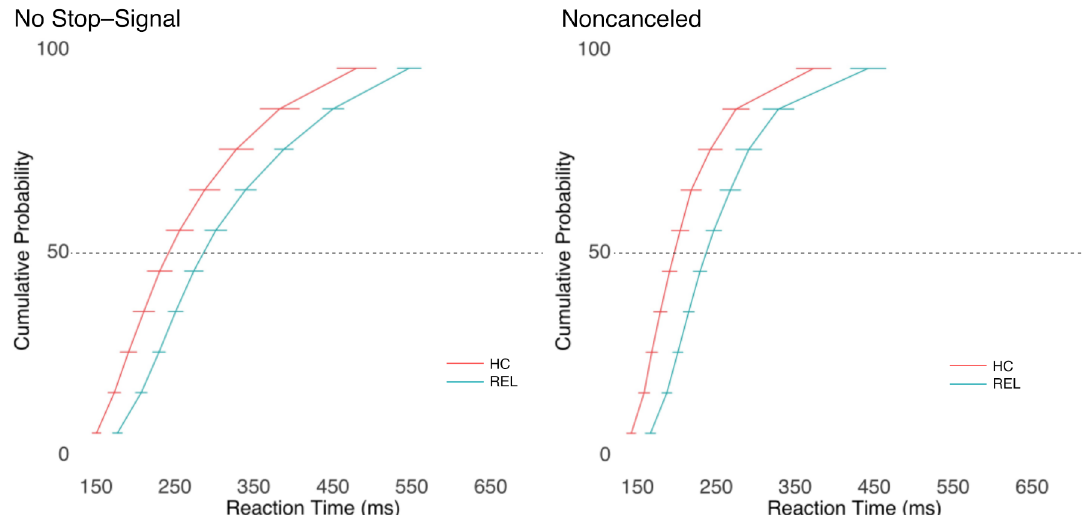
Figure 3. Vincentized RT distributions for no stop-signal trials ( left panel ) and noncanceled stop-signal trials ( right panel ) for experiment 1. The reaction times for each participant were binned into deciles split by trial type in order to visualize the distributions, which complimented the ANOVAs examining the mean reaction times that are reported in the main text. The decile means were averaged across participants for each group (REL and HC) to generate the distributions. Each error bar around each decile is the standard error of the mean RT within that